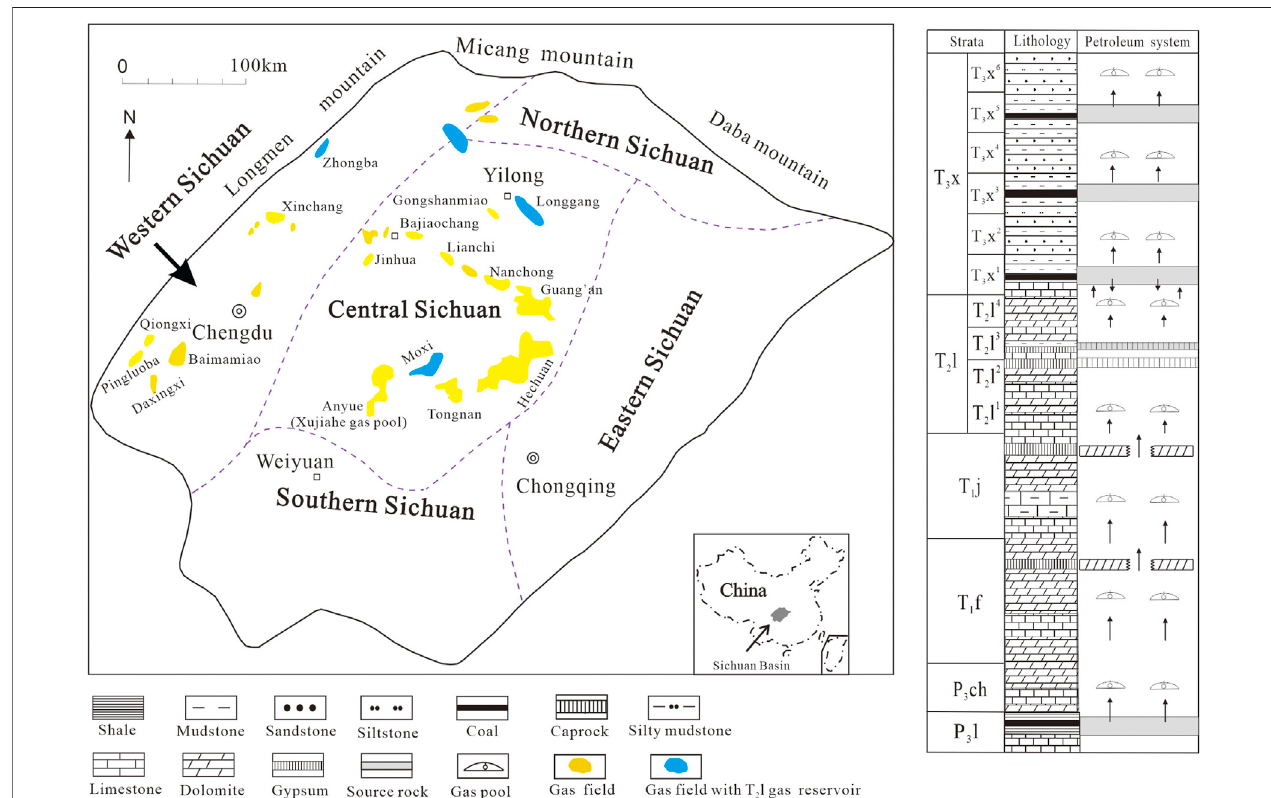
FIGURE 1 | Distribution of main gas fi elds and the Permian – Triassic petroleum system in the central and western Sichuan Basin.